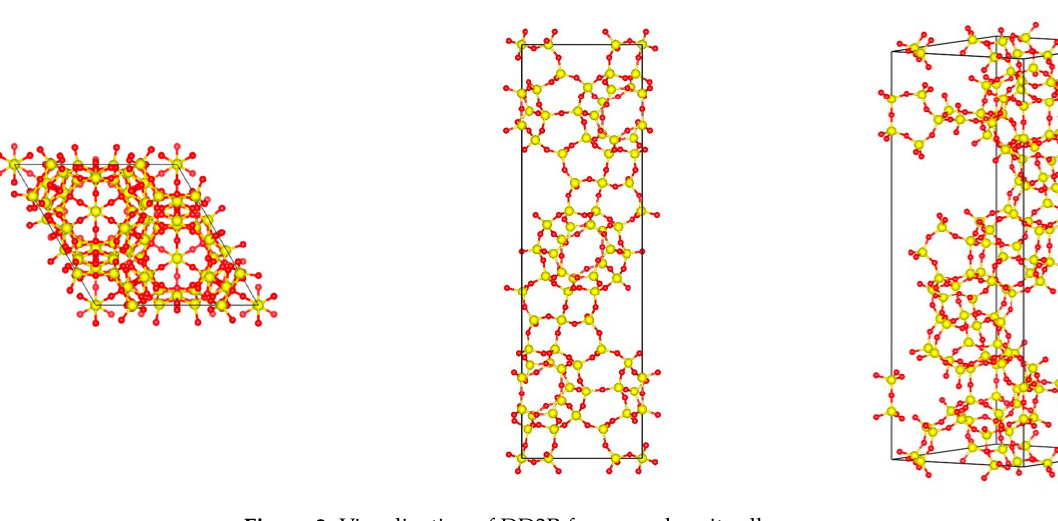
Figure 2. Visualization of DD3R framework unit cell.